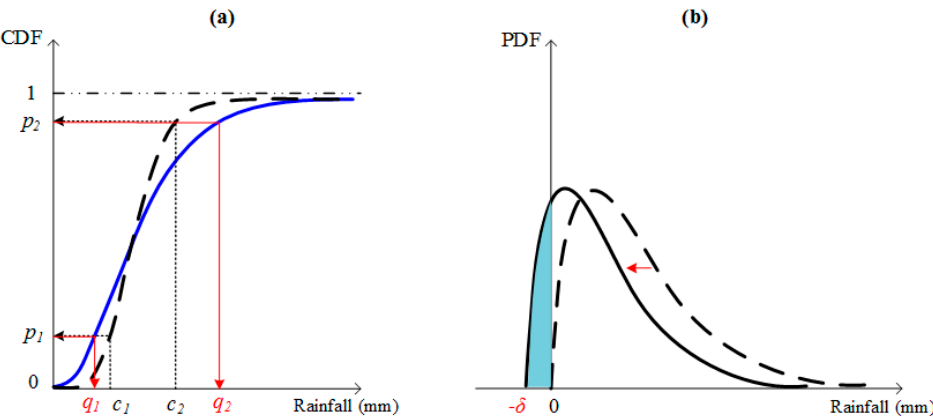
Figure 4. The schematic diagram of ( a ) transfer function of distribution mapping used in bias correction, and ( b ) the censored shifted change of parametric statistical